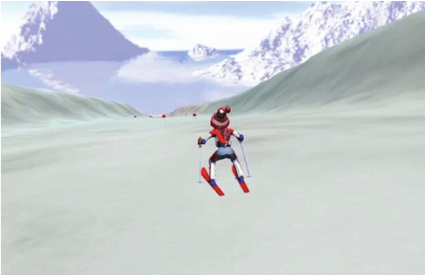
Figure 2: Screen snapshot of the skiing game.